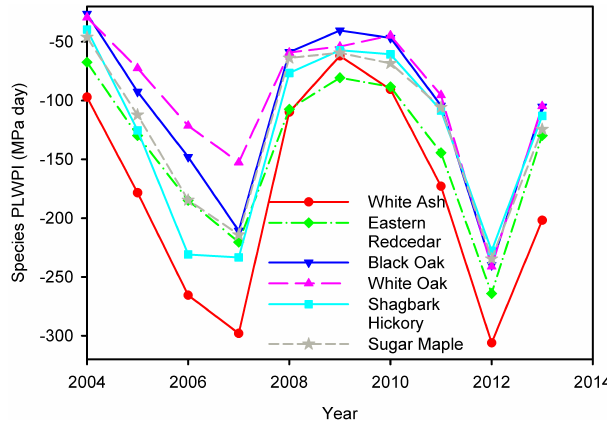
Figure 4. Inter-annual variations in PLWPI of different species from 2004 to 2013.